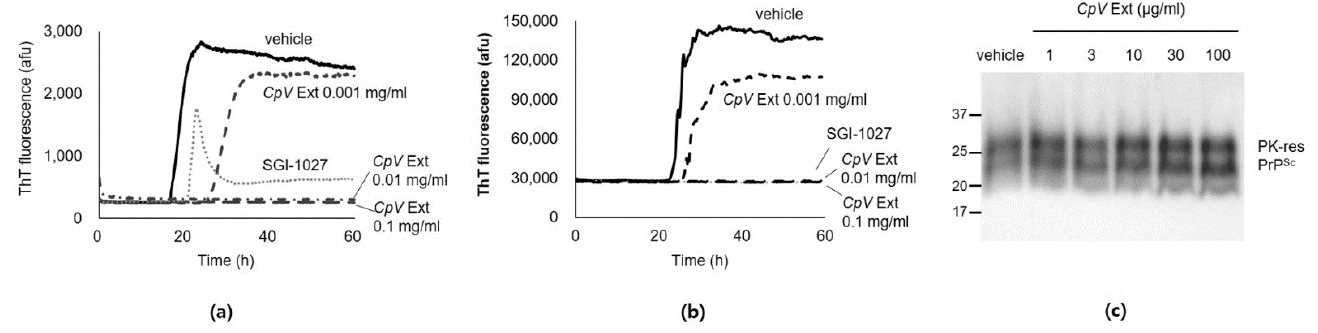
Figure 1. Inhibition of unfolded/misfolded rPrP aggregation by CpV extract. ( a ) Formation of guanidine hydrochloride-unfolded rPrP aggregates was monitored in the PAFA reactions with 0.001–0.1 mg/mL CpV extract (Ext). The PAFA with SGI-1027 (100 µ M) was used as a positive control. afu, arbitrary fluorescence unit. ( b ) Aggregation of misfolded rPrP converted from normal conformers through PrP Sc seeding was monitored using RT-QuIC assay with 0.001–0.1 mg/mL CpV extract. SGI-1027 was used as a positive control compound. ( c ) Western blotting of PK-resistant PrP Sc in SBH incubated with 1–100 µ g/mL CpV